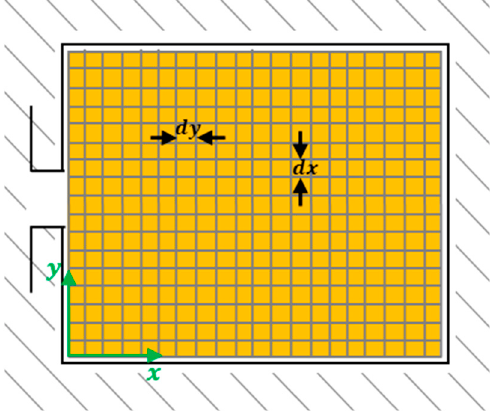
Figure 3. 2D grid on the slot.